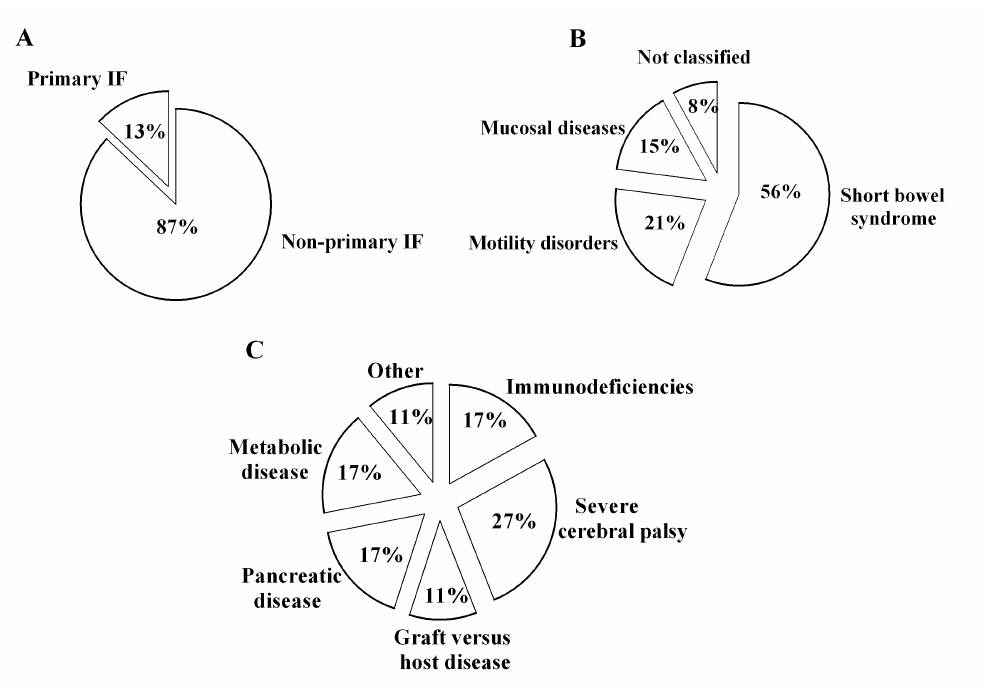
Figure 4. Indications for home parenteral nutrition programs. ( A ) Prevalence of primary and non-primary digestive diseases. ( B ) Etiology of primary digestive diseases. ( C ) Etiology of non-primary digestive